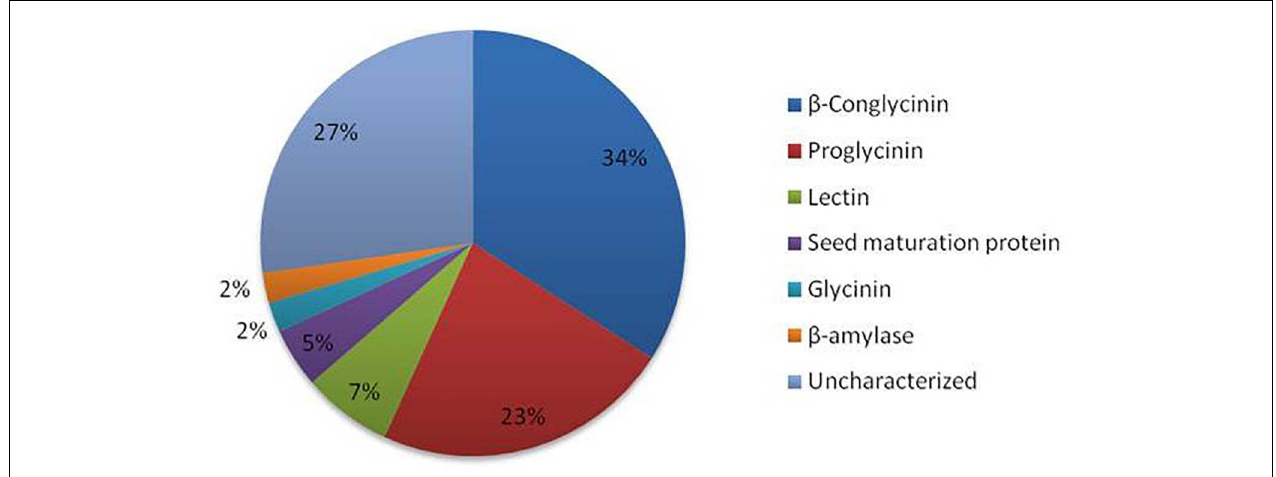
FIGURE 1 | Antiviral peptides identified in fermented soybean and their source